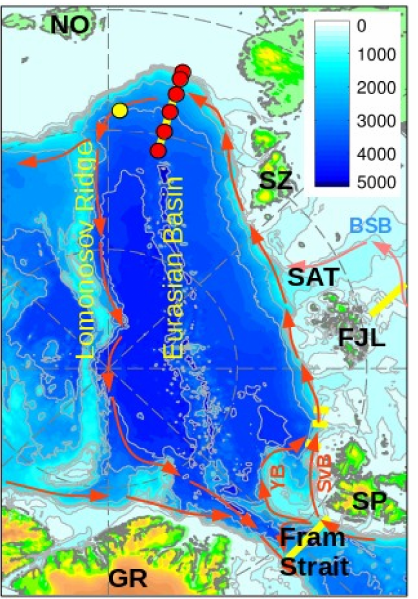
Figure 1. Map showing the location of moorings (red circles) over the continental slope of the Laptev Sea in the Eurasian Basin of the Arctic Ocean in 2013–2015. Greenland (GR), Spitsber- gen (SP), Franz Josef Land (FJL), St. Anna Trough (SAT), Sev- ernaya Zemlya (SZ), and Novosibirskiye Islands (NO) are indi- cated. YB, SvB, and BSB indicate Yermak, Svalbard, and Barents Sea Atlantic Water (AW) branches, respectively. Red arrows show a schematic pattern of AW circulation in the Eurasian Basin. Bot- tom depth in meters is shown by color. Oceanographic sections and moorings mentioned in the paper are indicated with yellow lines and